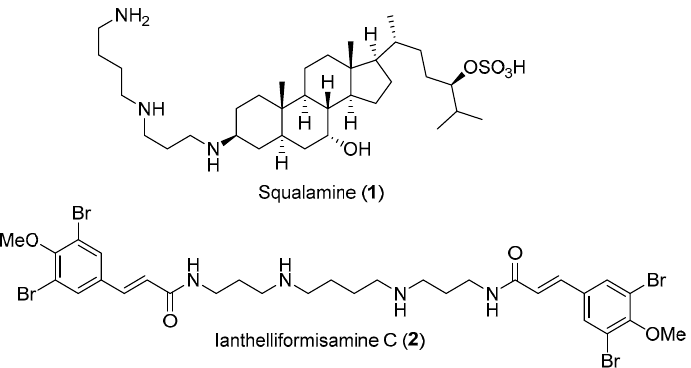
Figure 1. Structures of polyamine natural products 1 and 2 .